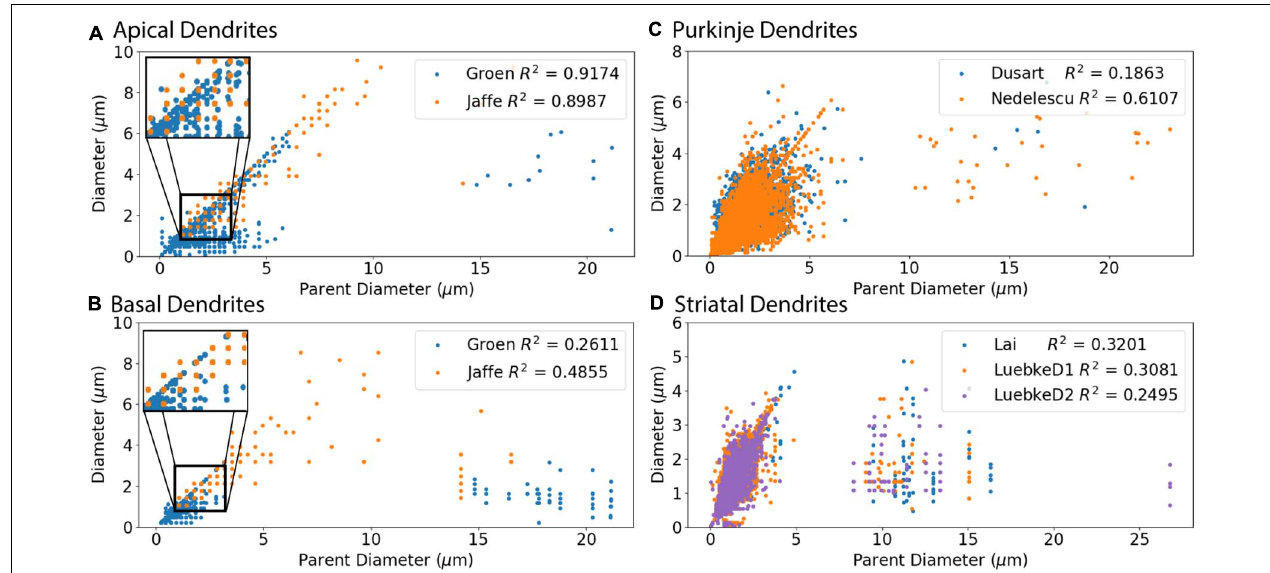
FIGURE 2 | Parent Diameter predicts diameter for multiple neuron types. R 2 as Pearson’s coefficient of determination for each archive. (A–D) A majority of nodes display a linear relationship between Parent Diameter and diameter, with a subset of nodes with large Parent Diameter departing from the relationship. (A) Apical dendrites of hippocampal pyramidal morphologies, with inset near origin showing the discretization of diameter values; Groen (CA1) with 130,070 nodes, Jaffe (CA3) with 8,483 nodes. (B) Basal dendrites of hippocampal pyramidal morphologies, with inset near origin; Groen (CA1) with 41,953 nodes, Jaffe (CA3) with 6,024 nodes. (C) Cerebellar Purkinje morphologies; Dusart with 19,664 nodes, Nedelescu with 46,748 nodes. (D) Striatal SPN morphologies; Luebke D1R (LuebkeD1) with 25,954 nodes, Luebke D2R (LuebkeD2) with 26,068 nodes, and Lai with 58,629